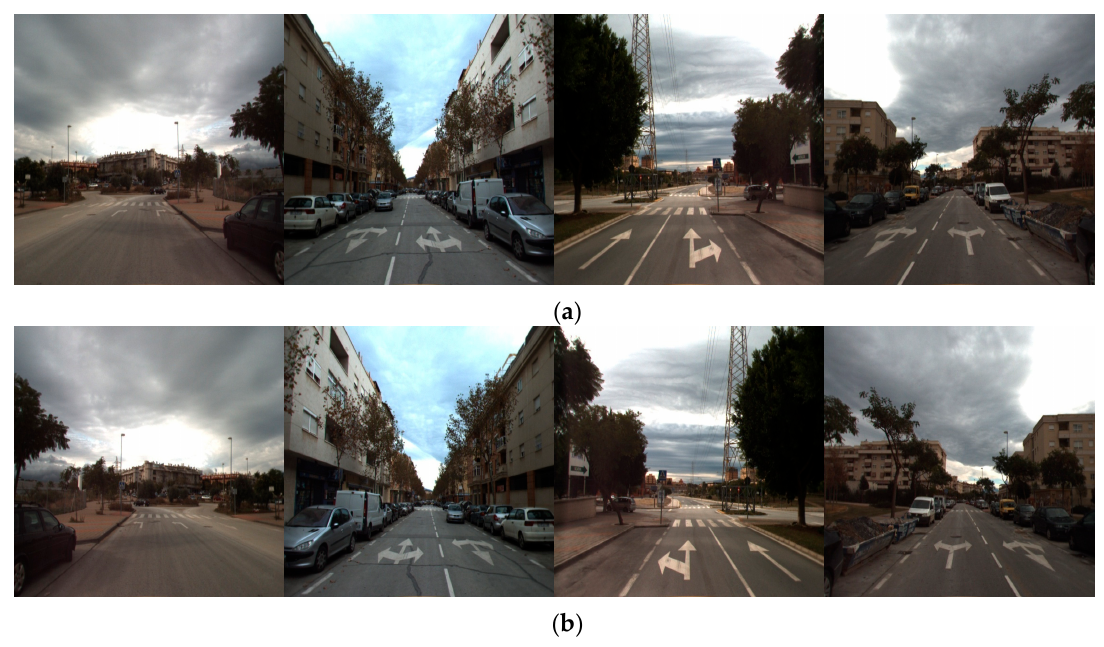
Figure 8. Examples of augmented images. ( a ) Original images. ( b ) Flipped images. Table 4. Number of images in original training, augmented training, and testing sets (unit: